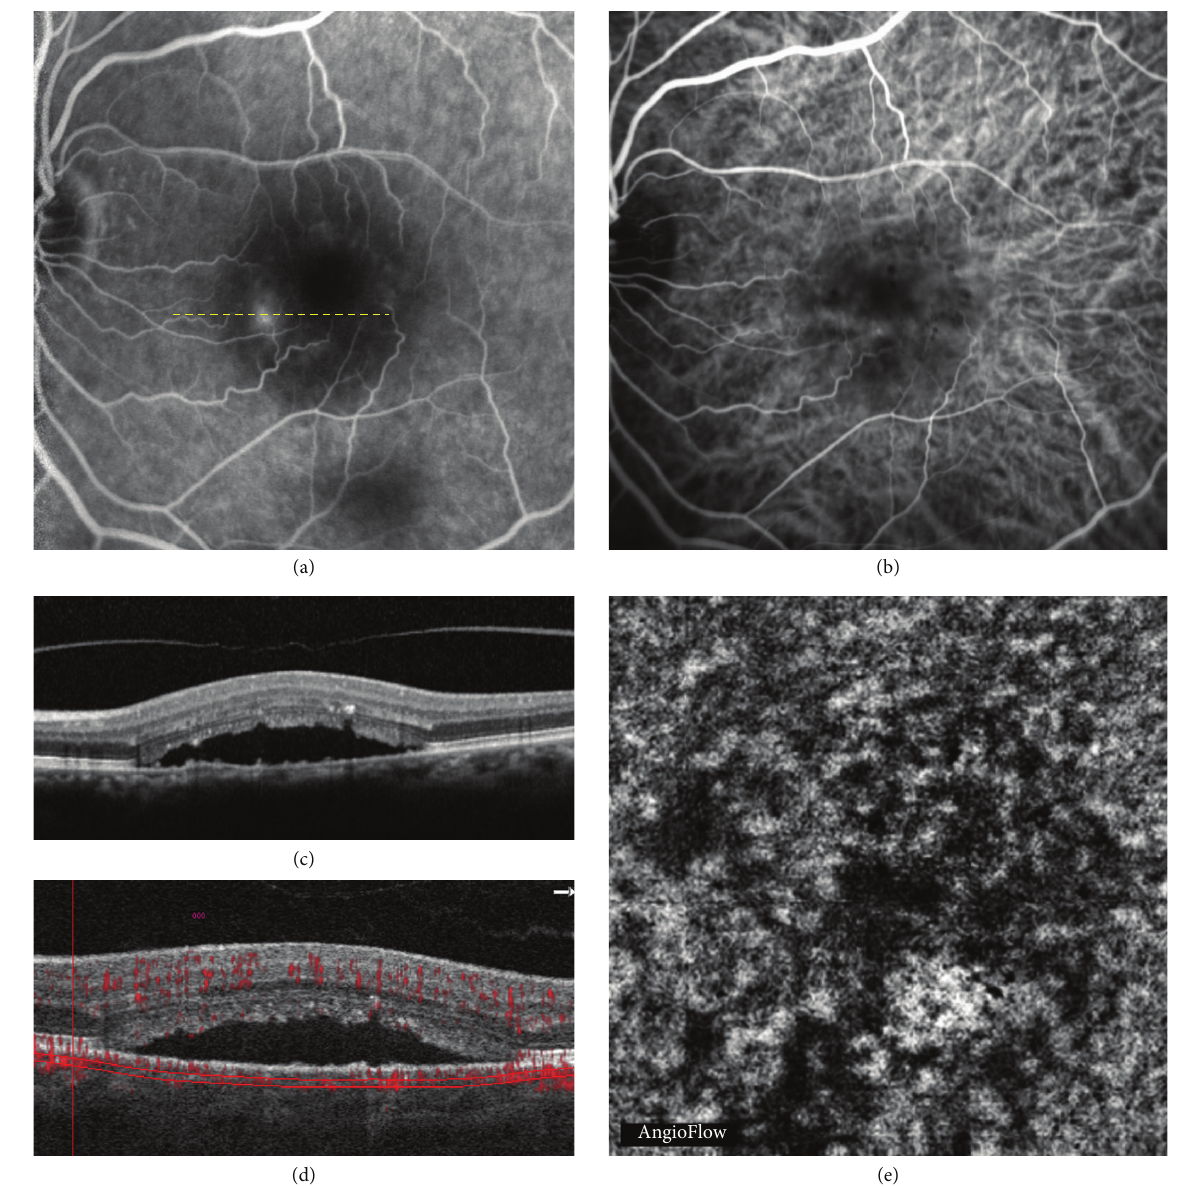
Figure 2: Chronic central serous chorioretinopathy in a 68-year-old woman. Correlation between fluorescein angiography (FA), indocyanine green angiography (ICGA), optical coherence tomography (OCT), and OCT angiography (OCTA). (a) Late phase of FA showing a typical leaking point; the yellow dashed line corresponds to the OCT scan shown in (c). (b) ICGA showing an abnormal dilation of choroidal vessels. (c) OCT B-scan showing a serous retinal detachment (SRD). (d) OCT B-scan showing the segmentation at the choriocapillaris shown in (e). (e) OCTA showing a dark area that corresponds to the SRD.